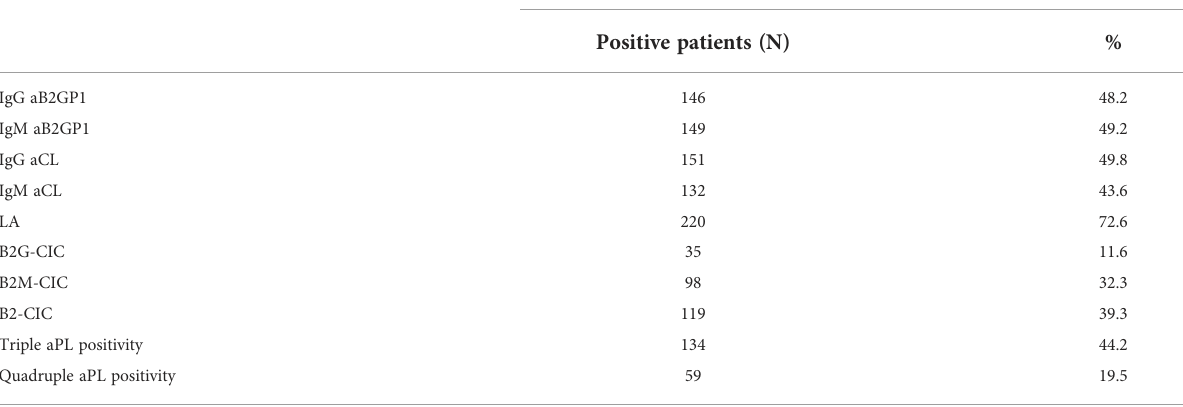
Table 1 Distribution of positive antiphospholipid antibodies and B2G/B2M-CIC in the 303 APS patients. ANTIPHOSPHOLIPID